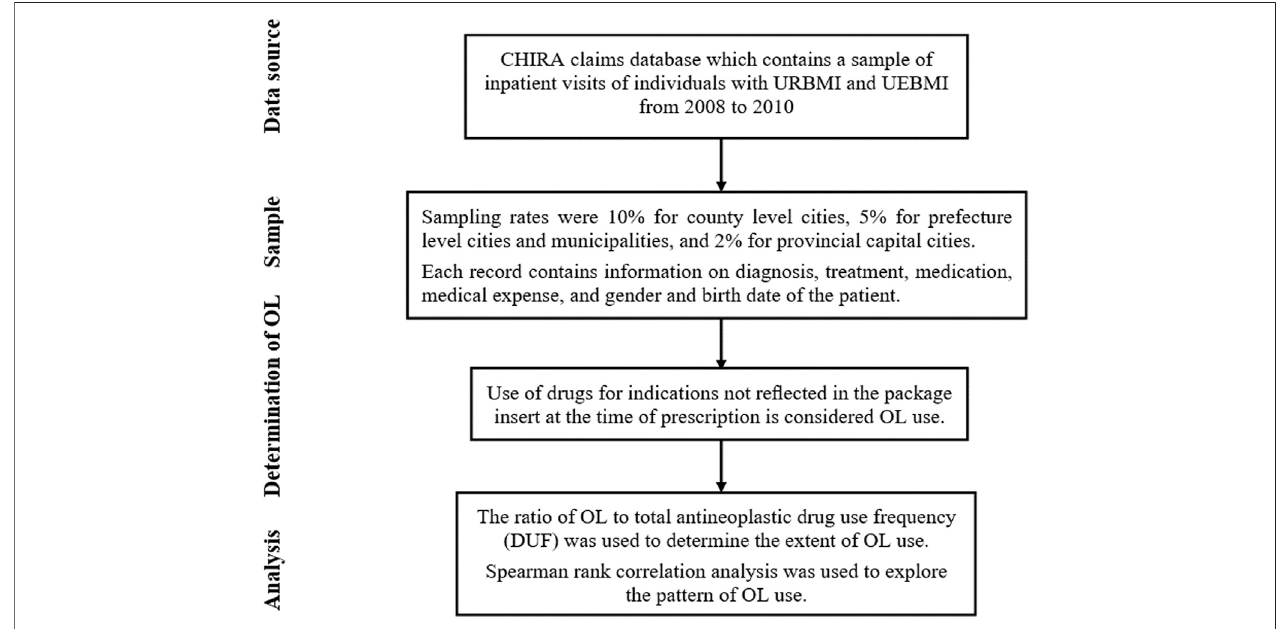
FIGURE 1 | Flowchart of the study